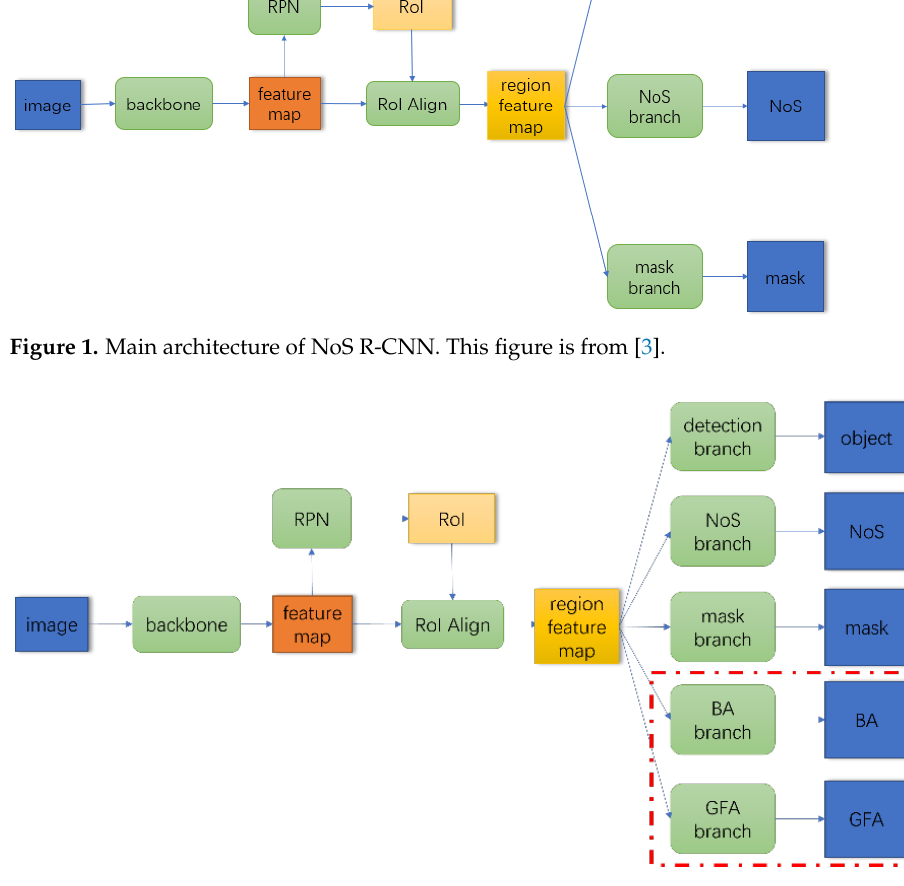
Figure 2. Main network architecture of proposed methods.